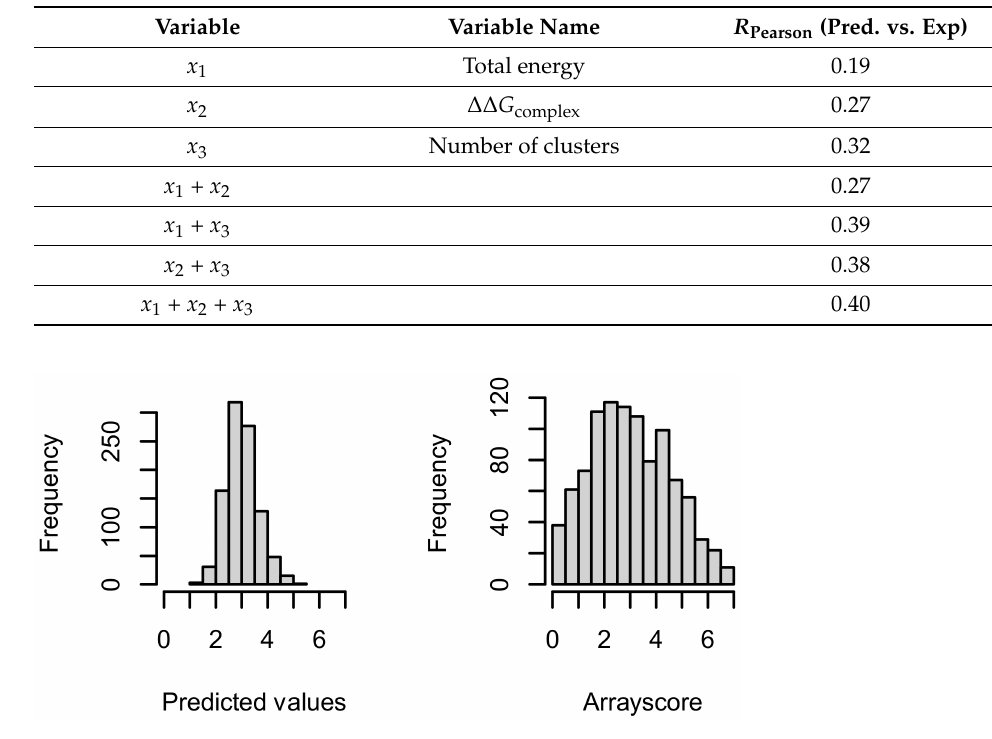
Figure 6. Distribution of the predicted and the experimental binding (arrayscore)